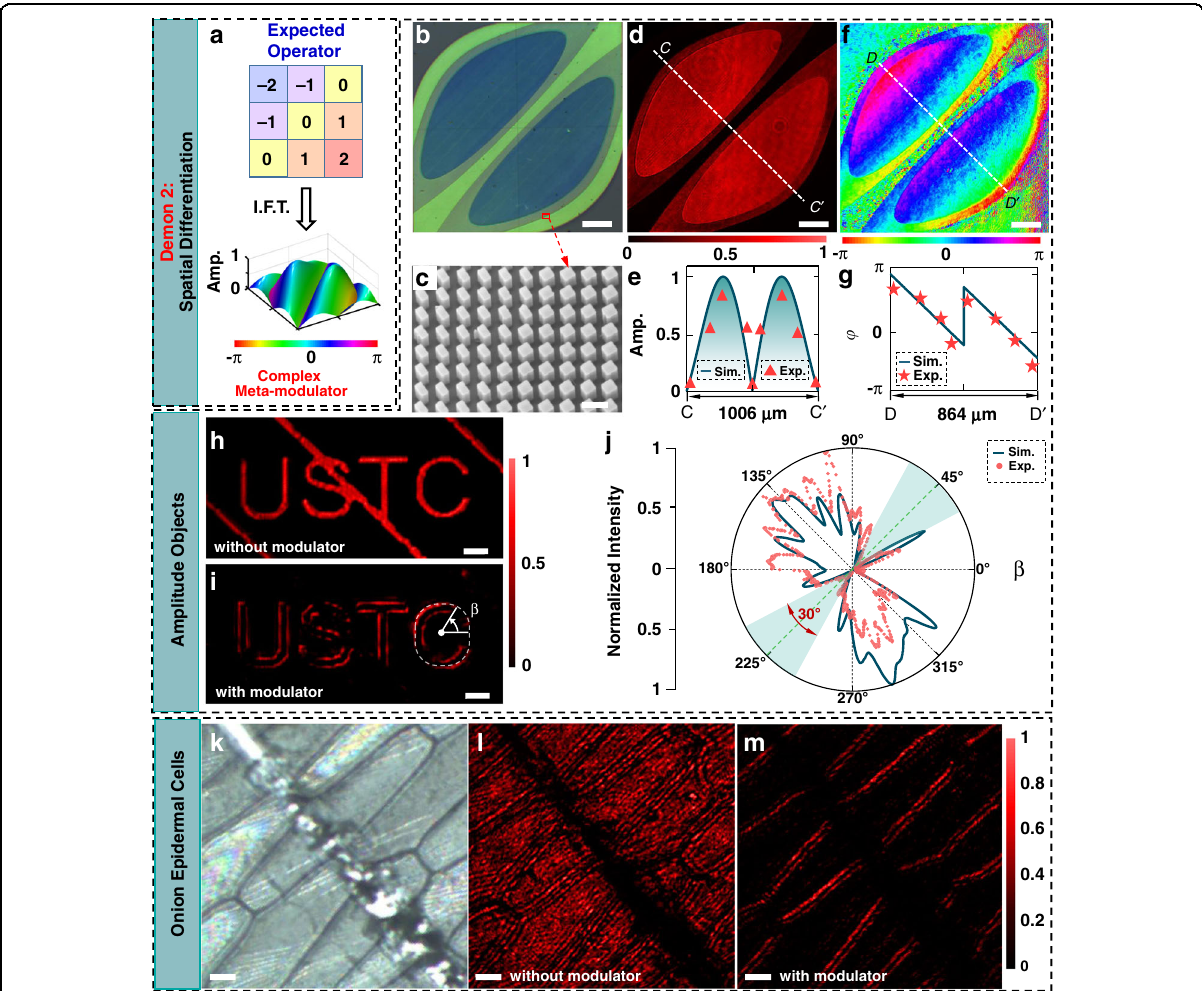
Fig. 3 Spatial differentiation. a Proposed operator (upper panel) and its related meta-modulator (low panel) for 135°-direction spatial differentiation. In the panel of meta-modulator, the pseudo-color denotes the phase. b , c Microscopic ( b ) and SEM ( c ) images of the fabricated meta- modulator with the corresponding w 0 = 1.5 μ m. The nanobricks having the same dimension as the edge-detection case are employed to realize three-level amplitude modulation. Scale bars: 100 μ m ( b ); 300 nm ( c ). d Transmission (cross-polarization part) of the fabricated meta-modulator under the circular-polarized illumination. Scale bar: 100 μ m. e Simulated (curve) and experimental (triangles) line-scanning amplitude pro fi les along the line CC ′ (denoted in ( d )). The experimental amplitude are obtained by using a square root of the transmission in ( d ). f Retrieved phase pro fi les from the experimental interference patterns. Scale bar: 100 μ m. g Simulated (curve) and experimental (stars) phase pro fi les along the line DD ′ (denoted in ( f )). h Original object was obtained by using a single metalens without the modulator. Scale bar: 20 μ m. i Processed the image by our meta-imager with the modulator. The 135°-direction lines in ( h ) are removed by the designed spatial differentiator. To test the directionality of this spatial differentiator, the azimuthal coordinate β is sketched along the outmost edge (shown in a white-dashed curve) of the processed character “ C ” . Scalebar: 20 μ m. j Simulated (curve) and measured (dots) intensity pro fi les of “ C ” pattern at the azimuthal coordinate β (sketched in ( i )). The edge of the character “ C ” is removed around the 45° – 225° line with a range of 30°. k – m Microscopic image ( k ) of onion epidermal cells contaminated by an opaque needle. After being imaged (with a magni fi cation of 1.5) by an objective lens, the magni fi ed cells ( l ) immediately operate as the input of our meta-imager ( M = 1), which creates the edges ( m ) of these onion cells at the image plane. Scale bars: 20 μ m in ( k ); 30 μ m in ( l , m